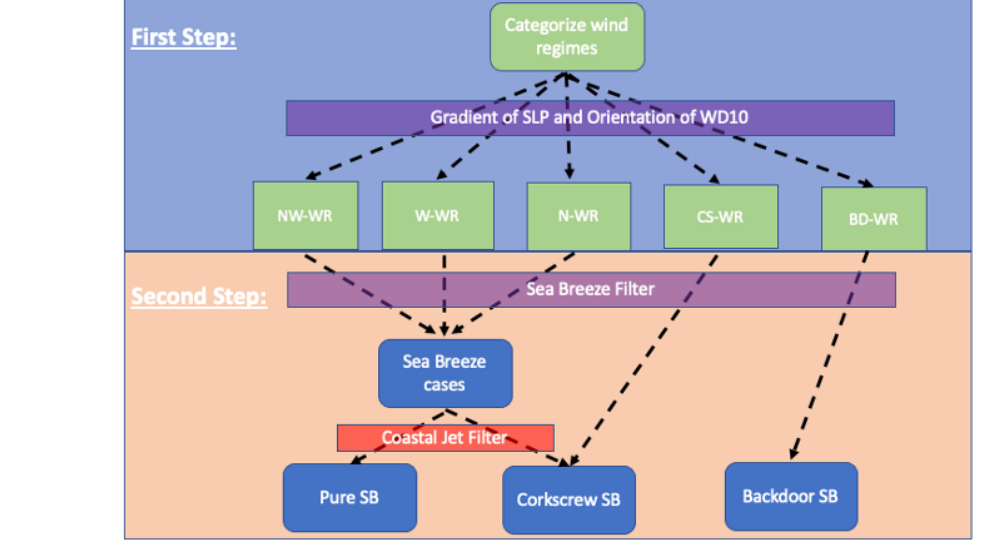
Figure 2. Flow diagram showing the filters involved in the sea breeze identification method for the 1-year (September 2019–August 2020) simulation period. SLP, WD10, SB and WR stand for sea level pressure, wind direction at 10m, sea breeze and wind regime respectively.